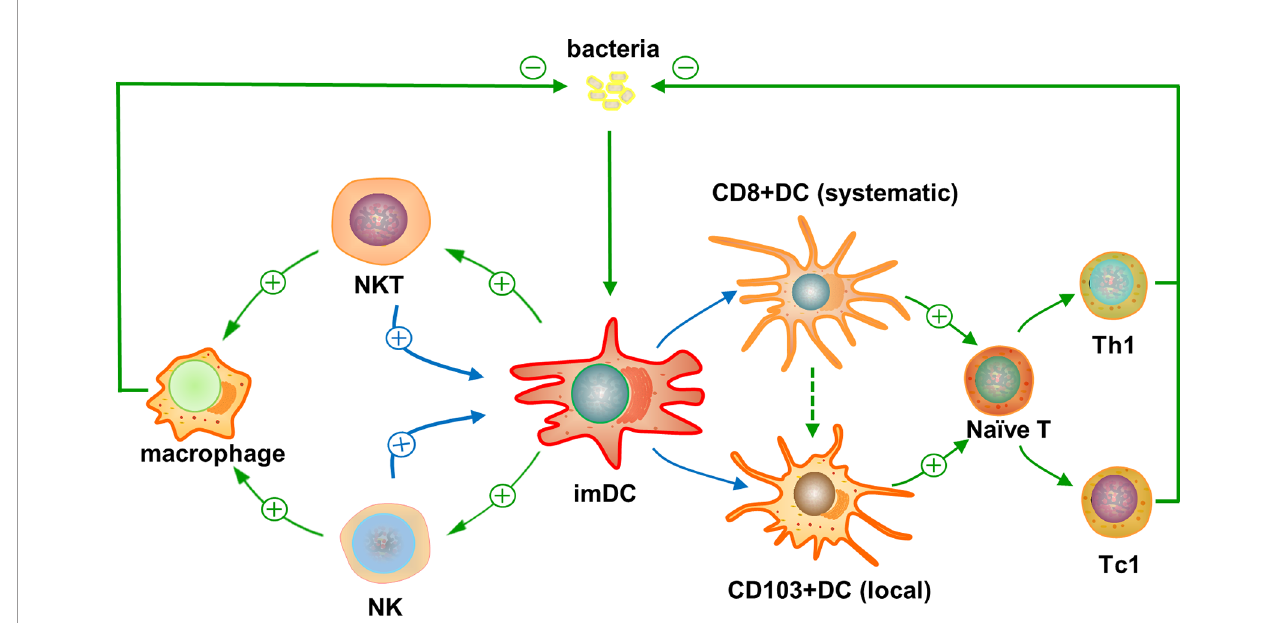
FIGURE 1 | Reciprocal interaction of natural kill T (NKT) cells and dendritic cells (DCs) and its impact on T cell responses against infections. The entered bacterial or some other infectious agents are taken by immature DCs and their microbial lipid antigens are presented through CD1d to activate NKT cells. The activated NKT cells can feedback on the DCs promoting their maturation and preferential differentiation to CD8 a + DCs, systemically, and CD103+ DCs in local tissues. Possible molecular and functional link between CD8 a + and CD103+ DC subsets has been suggested. The preferentially-promoted DC subsets can direct the differentiation of conventional CD4+ or CD8+ naïve T cells into functional Th1- or Tc1-like peptide antigen-speci fi c T cells, respectively, due to their predominant expression of co- stimulatory surface markers and production of cytokines for type 1 T cell responses. The activated antigen-speci fi c CD4+ Th1 and CD8+ Tc1 T cells can inhibit the infectious agents locally and systemically. In addition, the feedback of NKT cells on immature DCs can lead to enhanced activation of NK cells, which also have positive feedback effect on DCs for their function to promote type 1 T cell responses. This indirect interaction of NKT and NK cells through DCs can amply the positive feedback of NKT cells on DC function. Moreover, the activated NKT and NK cells can promote the function of local monocytes and macrophages to inhibit the infection. Symbols and abbreviations: ⊕ , promote; ⊝ , inhibit; imDC, immature DC; naïve T, naïve T cell; Th1, CD4+ type 1 T cell; Tc1, CD8+ type 1 T